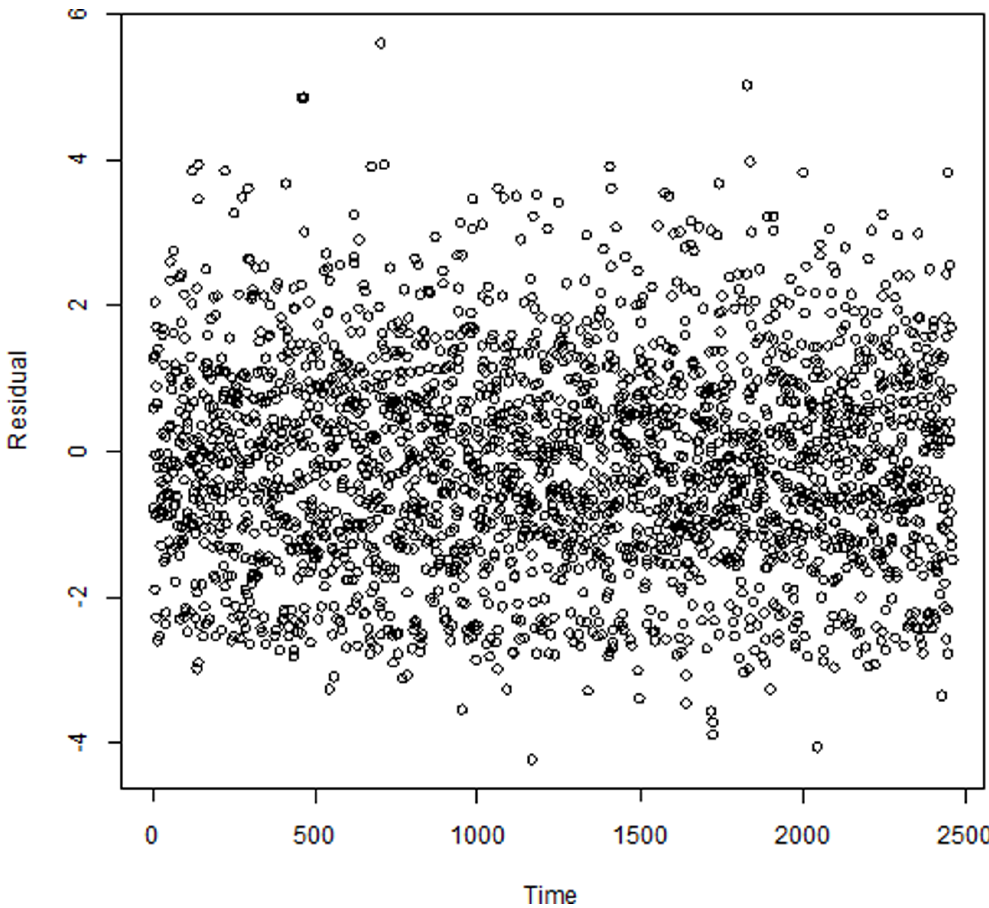
Figure 4. The scatter plot of residuals over time.